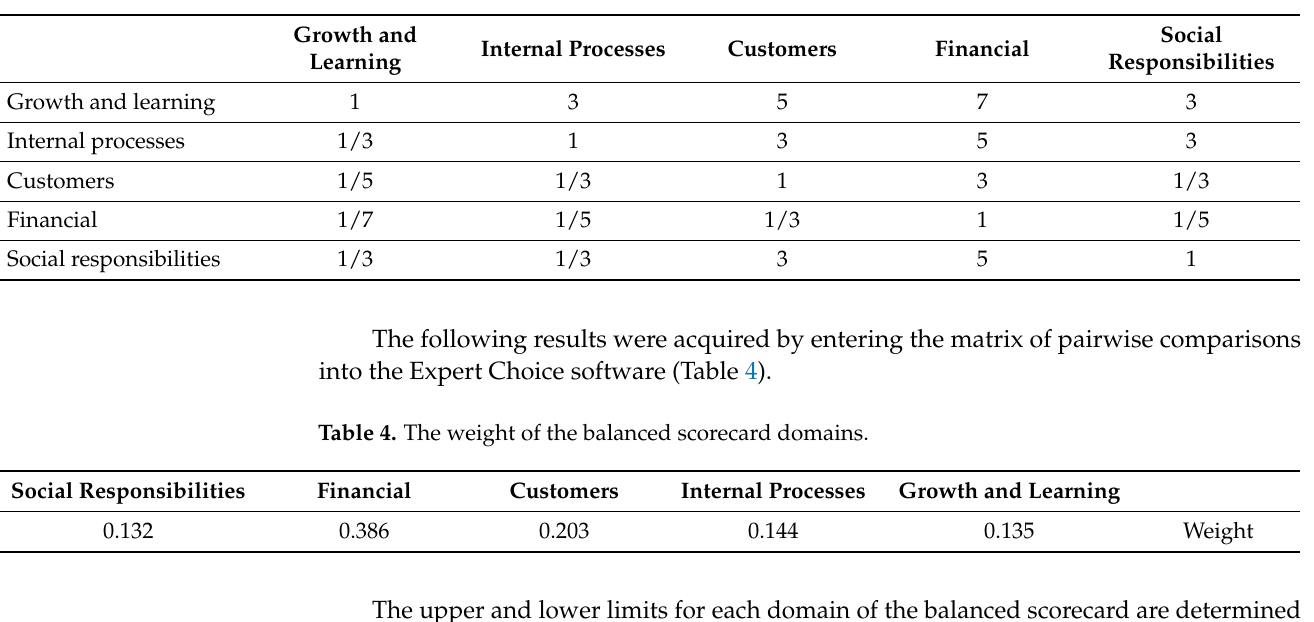
Figure 7. Hierarchical organization of a balanced scorecard. Table 3. Balanced scorecard dimensions of pairwise comparison matrix.